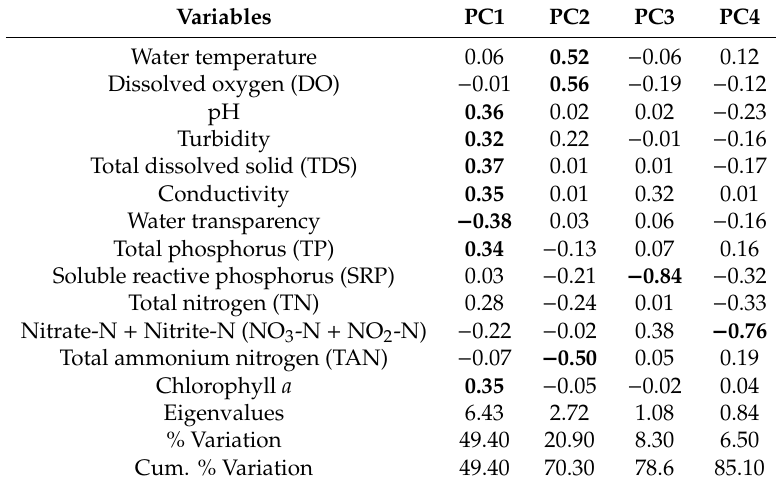
Bold fonts indicate major variables that contributed to principle components